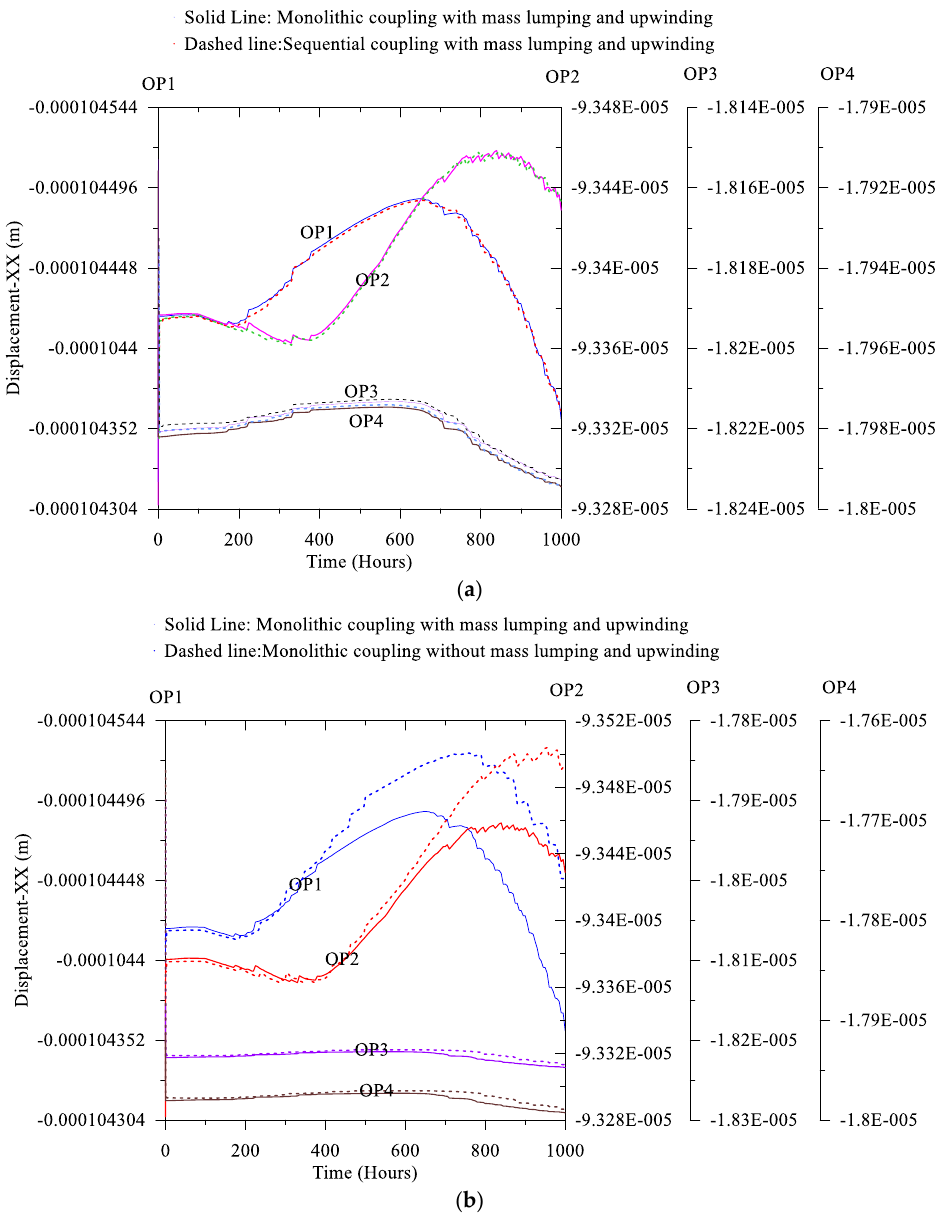
Figure 11. Comparisons of the displacement along the X -axis: ( a ) the monolithic coupling and the sequential coupling and ( b ) with and without the mass lumping and the upwinding.